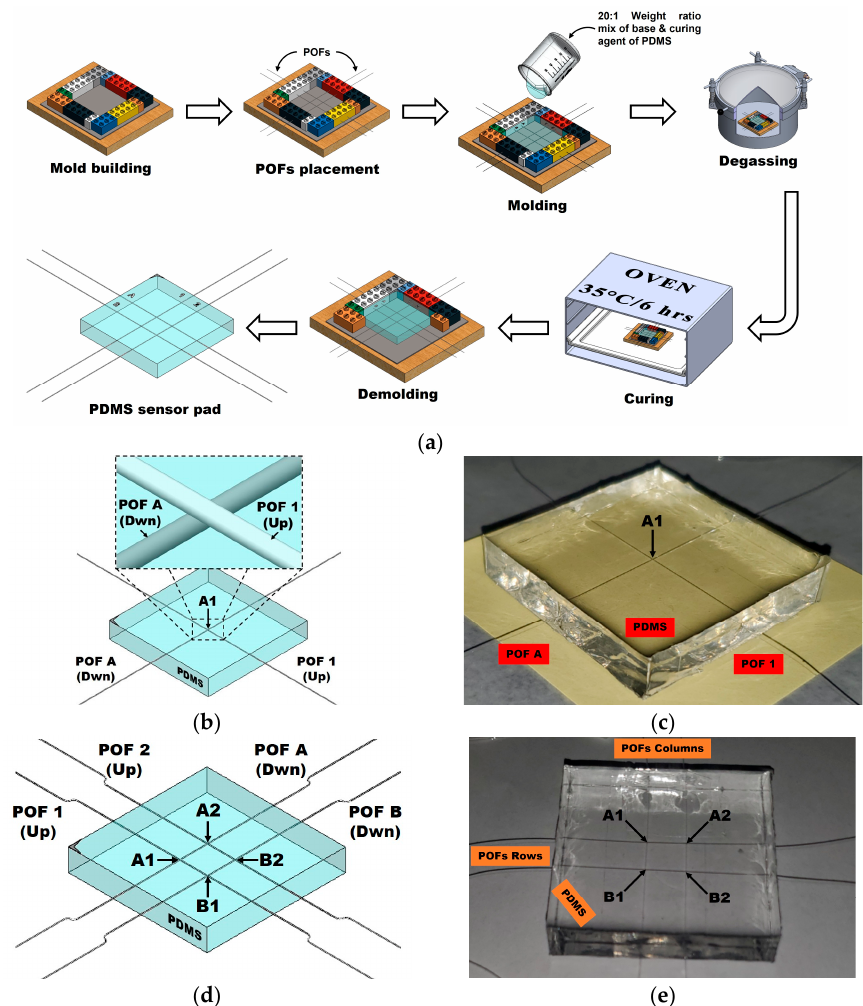
Figure 1. ( a ) Graphical representation of the manufacturing process of molding the sensor pads; ( b ) 3D model of the sample of 1 POF × 1 POF and the pressure point (A1) resulting from the intersection of the fibers; ( c ) real photo of the 1 POF × 1 POF sample and its pressure point A1; ( d ) 3D model of the 2 POFs × 2 POFs sample and its pressure points resulting from intersection of the fibers (A1, A2, B1, B2); ( e ) real photo of the 2 POFs × 2 POFs sample and its pressure points (A1, A2, B1,